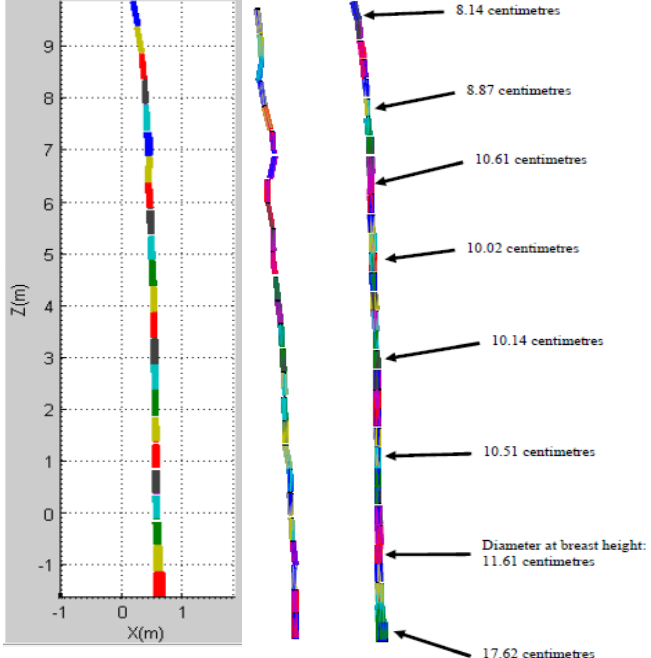
Figure 7. Cylinder fitting applied to point clouds of the stem showing the diameter profile from the bottom to the top of a stem. Forests 2016 , 7 , 86